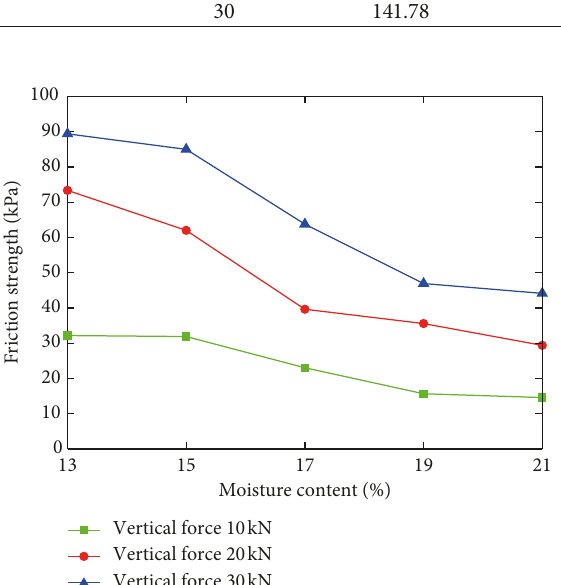
Figure 6: Friction strength of the paraffin-oil mixture on the concrete surface and soil for different moisture